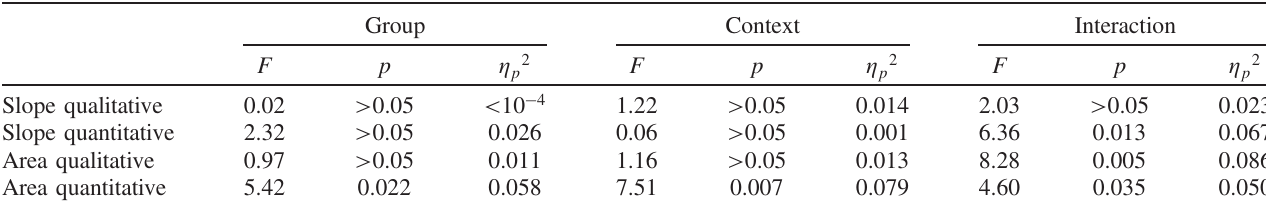
FIG. 7. Average viewing time on the AOI Axes of the physics and psychology students in the context of physics and finance on the qualitative and quantitative questions about graph slope and area under a graph. The error bars represent 1 SEM. TABLE V. Results of the two-way ANOVAs conducted on the students ’ total viewing times on the qualitative and quantitative questions about graph slope and area under a graph with the between-subjects factor group (physics students vs psychology students) and within-subjects factor context (physics vs